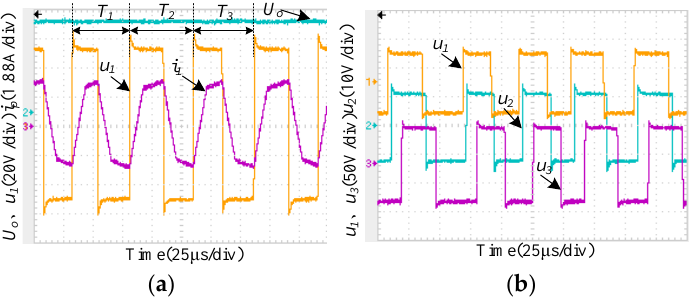
Figure 23. Measured waveforms of shifted-phase angle control using discretely chaotic modulation: ( a ) converter voltage, current of port 1 and output voltage of port 2; ( b ) converter voltages of port 1, 2 and 3.